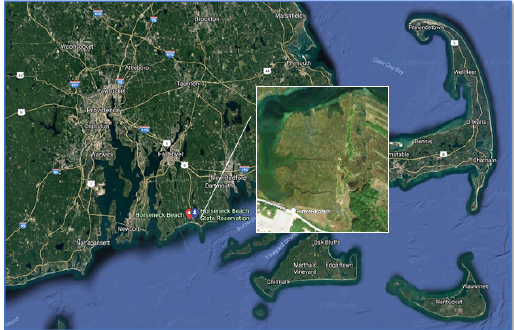
Figure 1. Imagery 2018 Landsat / Copernicus, Data SIO, NOAA, U.S. Navy, NGA, GEBCO, U.S. Geological Survey,